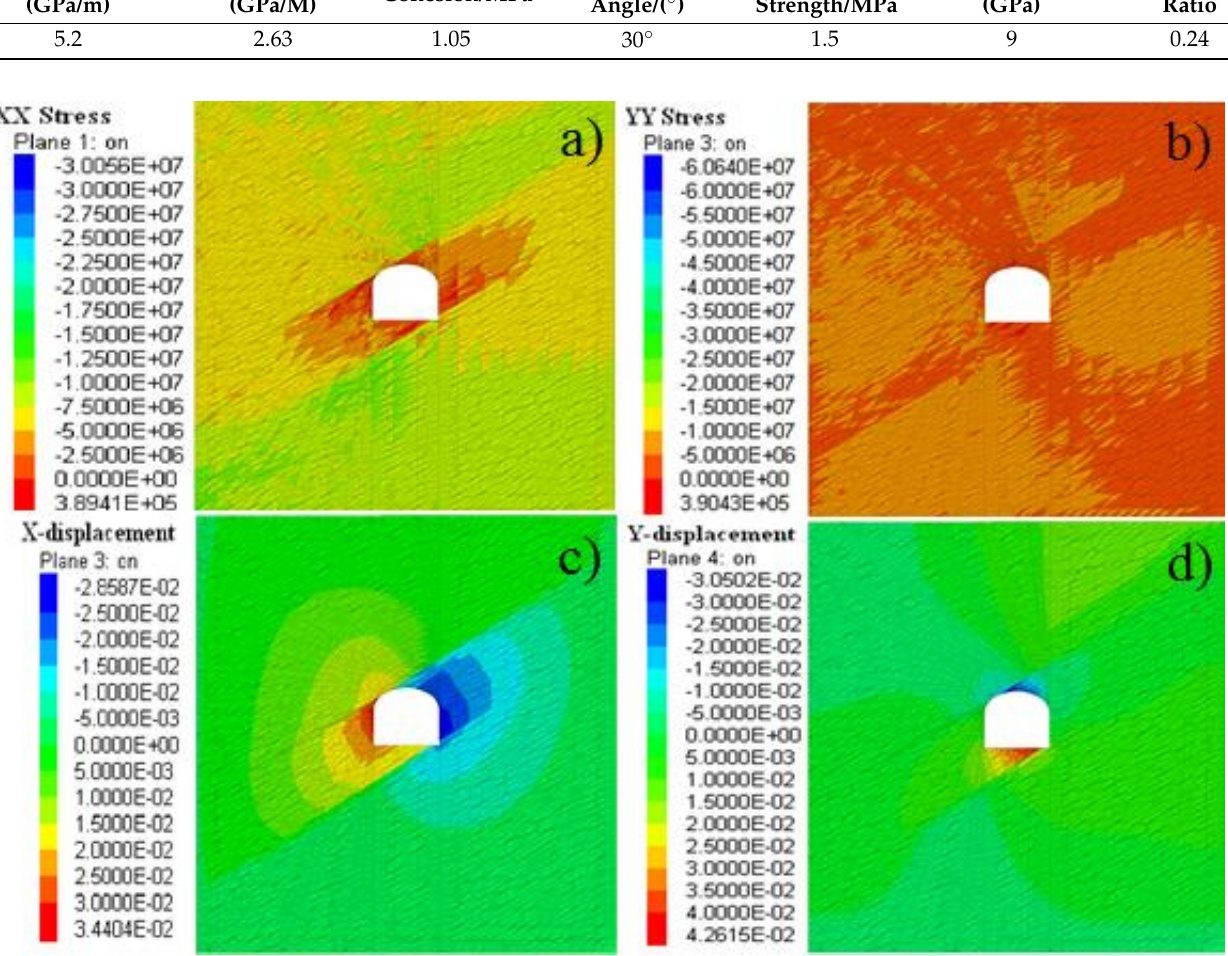
Figure 10. The stress contour diagrams and displacement contour diagrams in the vertical and horizontal direction. Note: ( a ) Horizontal stress distribution; ( b ) vertical stress distribution; ( c ) Horizontal displacement distribution; ( d ) vertical displacement distribution.